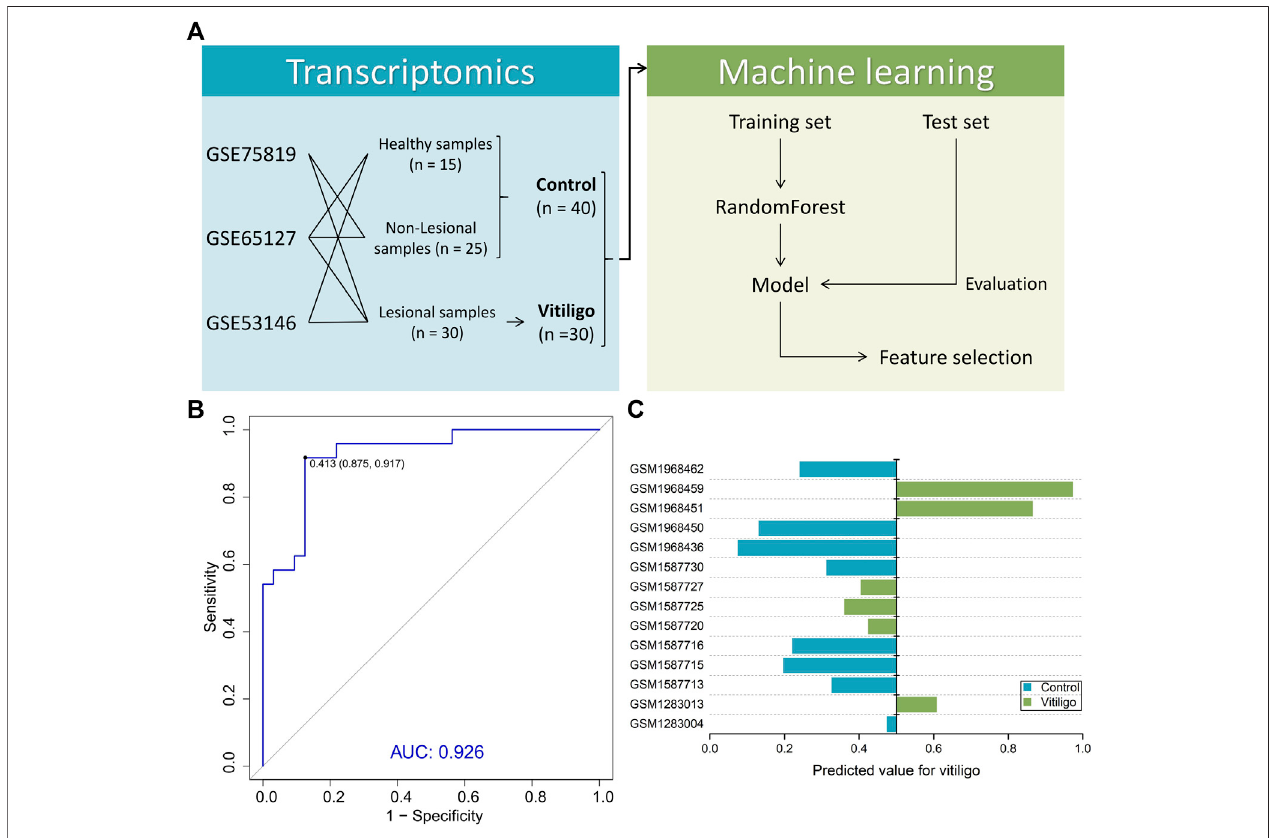
FIGURE 3 | Important transcriptomic features for vitiligo prioritized by random forest analysis.